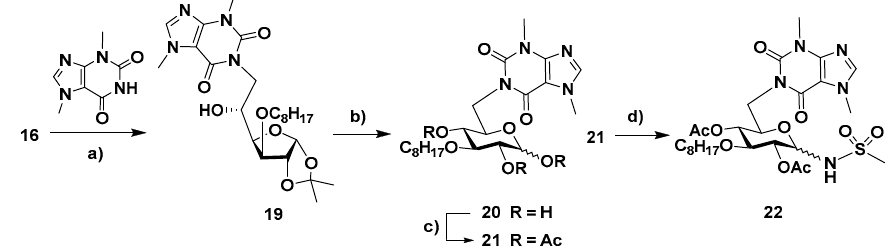
Table 1. Results of the evaluation of the inhibitory activities of the compounds on